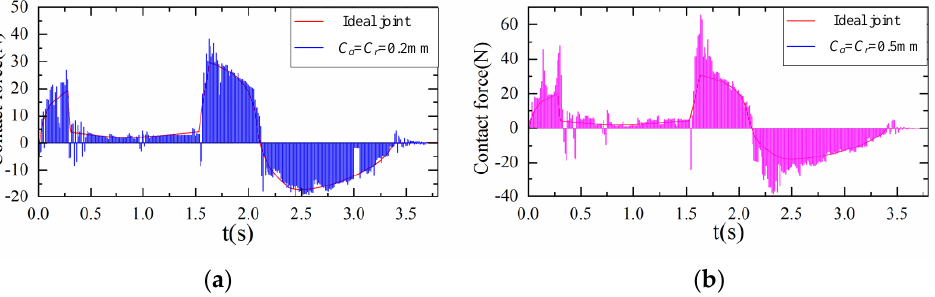
Figure 13. Contact force of joint B in the X direction. ( a ) The contact force in the X direction when both clearances are 0.2 mm and ( b ) the contact force in the X direction when both clearances are 0.5 mm.